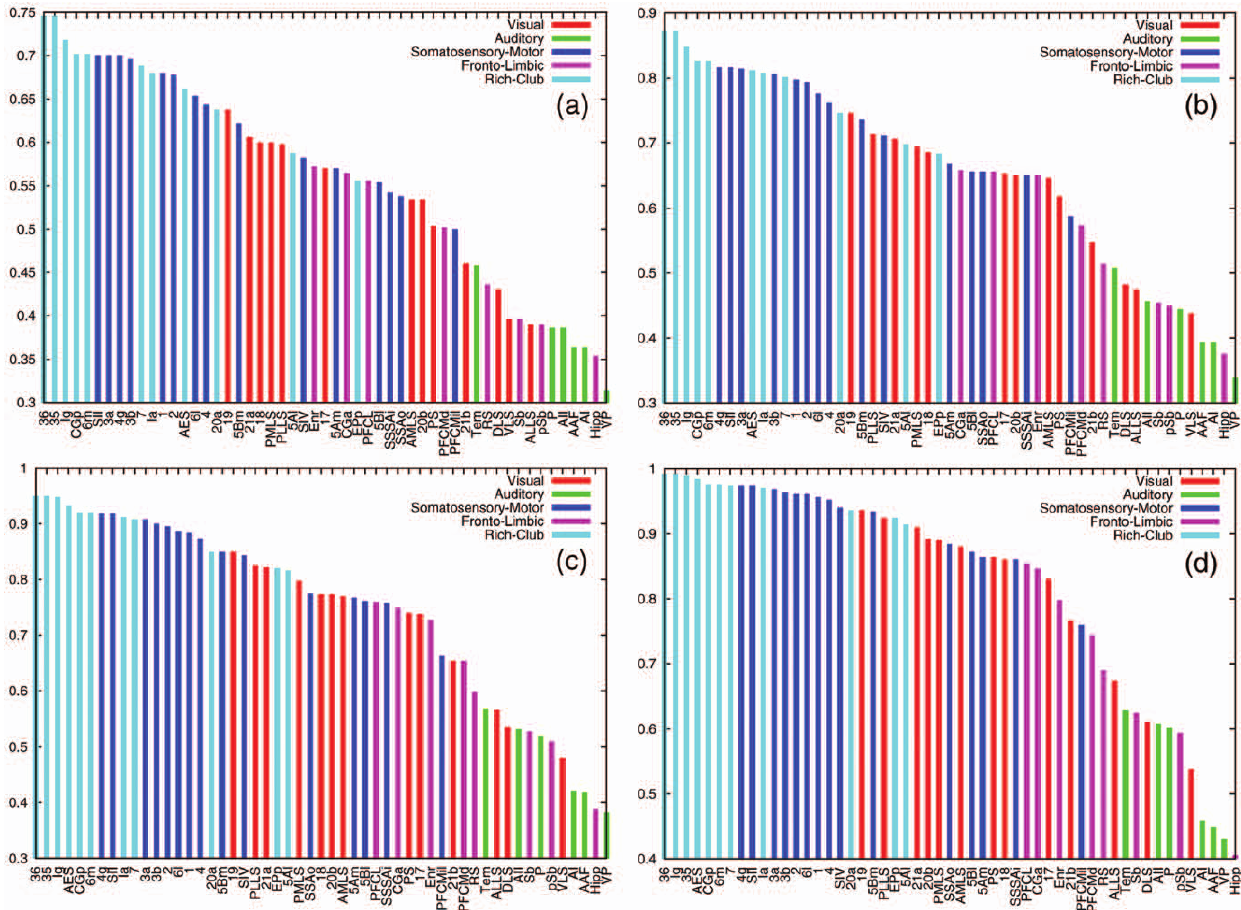
Figure 6. Synchrony Rank of areas: Structure of the largest synchronized areas as described by the Rich-Club. The two plots show the same synchrony ranks as in Figure 5 (again l ~ 0 : 015 (a), 0 : 017 (b), 0 : 019 (c) and 0 : 021 (d)). We have recolored the bars of those areas corresponding to the Rich-Club to highlight the dominant role of this topological structure in the composition of the largest synchronized areas.